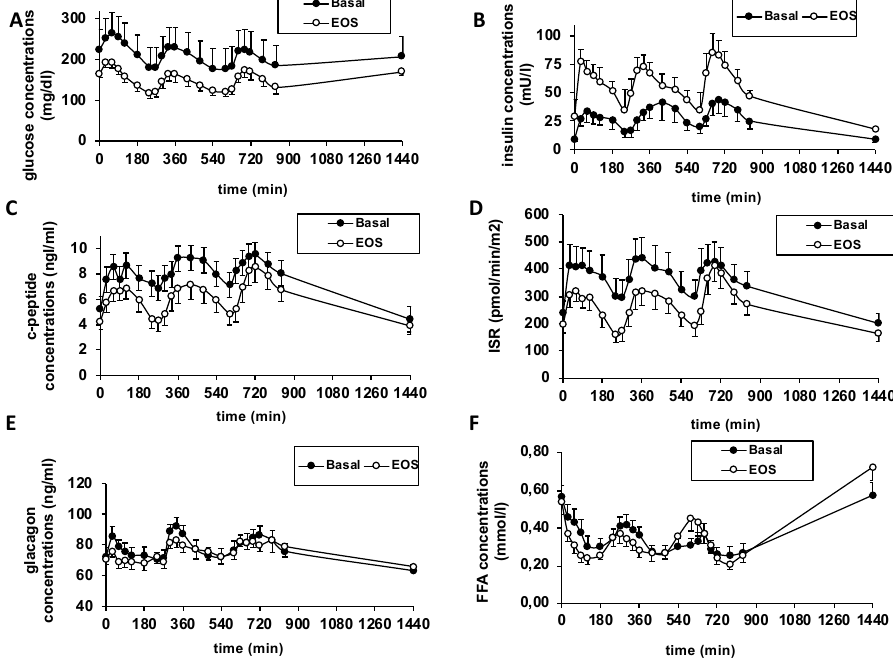
Figure 2. 24-hr glucose profile before (Basal) and after (EOS) 16 weeks of treatment with Inhaled insulin. Glucose ( A ), insulin ( B ), C-peptide ( C ), ISR (insulin secretion rate, D ), glucagon ( E ) and FFA ( F ) concentrations.